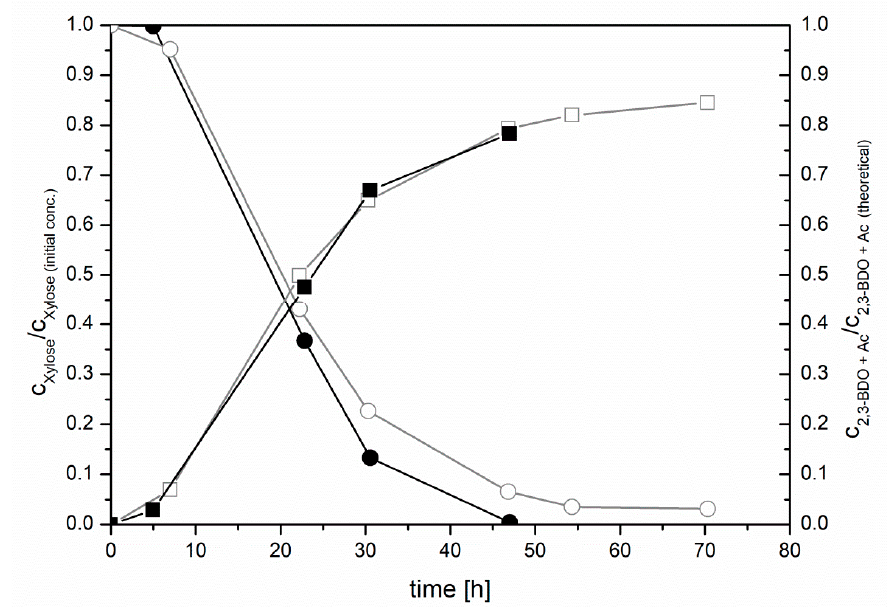
Figure 5. Comparison of fermentation courses of pure xylose (black, closed symbols) and hydrolysed hemicellulose extract concentrated by ultrafiltration (UF) and reduced in acetate concentration (grey, open symbols) with B. vallismortis B-14891. Normalized substrate concentration and product formation (2,3-BDO + acetoin). Cultivations were performed in a 250 mL reactor with a filling volume of 100 mL, 37 ◦ C, aeration rate of 25 sL / h and 300 rpm. Initial pH for xylose was 6.6 ± 0.1 and pH control at pH 5.8 with 4 M NaOH during the cultivation.